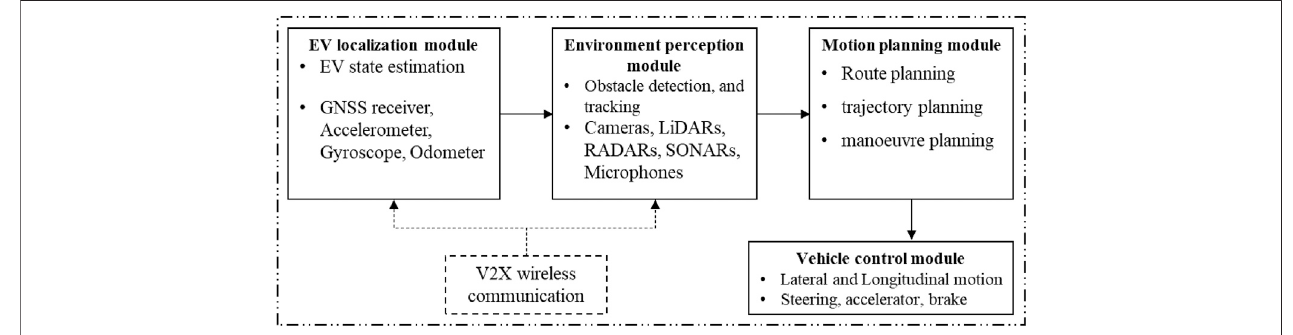
FIGURE 1 | Primary modules in an